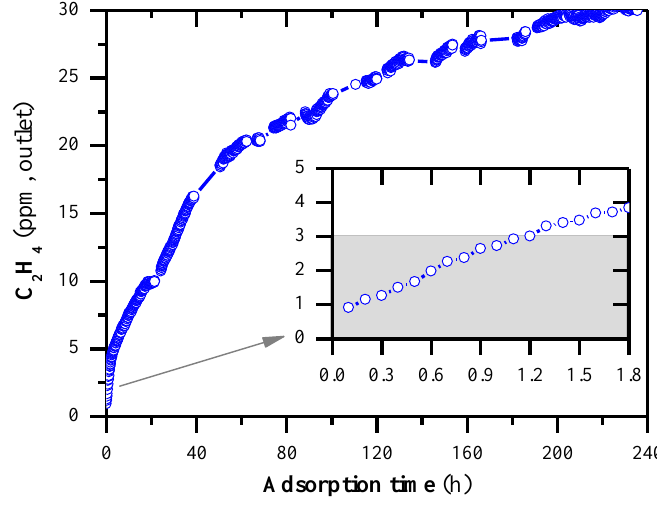
Figure 1. Evolution of C 2 H 4 concentration in the gas outlet of the corona discharge-coupled catalytic reactor (C 2 H 4 concentration inlet: 30 ppm; Pd/ZSM-5: 26 g; total flow rate: 2 L/min).